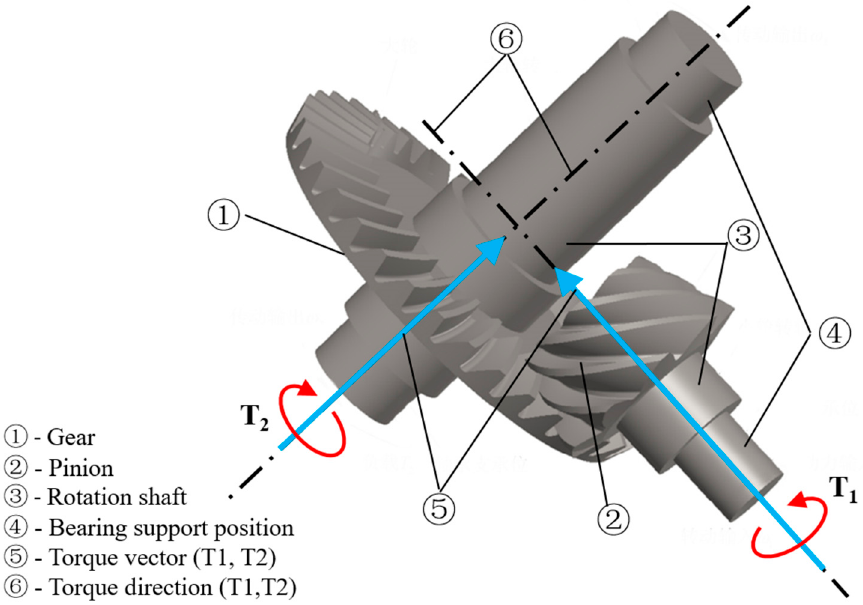
Figure 8. Simplified spiral bevel gear transmission system.